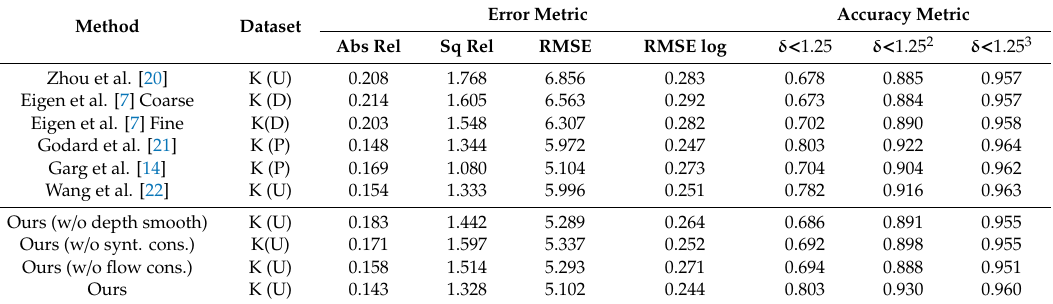
Table 1. Monocuar depth estimation result on KITTI dataset [23]. K denotes the KITTI dataset. (U) is unsupervised approach. (D) represents depth supervision, and (P) denotes pose